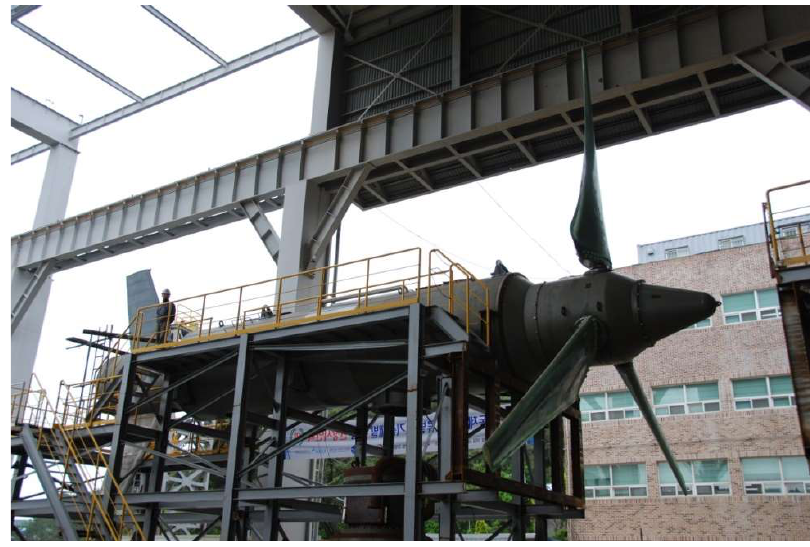
Figure 10. A photo of 200 kW active-controlled TEC.